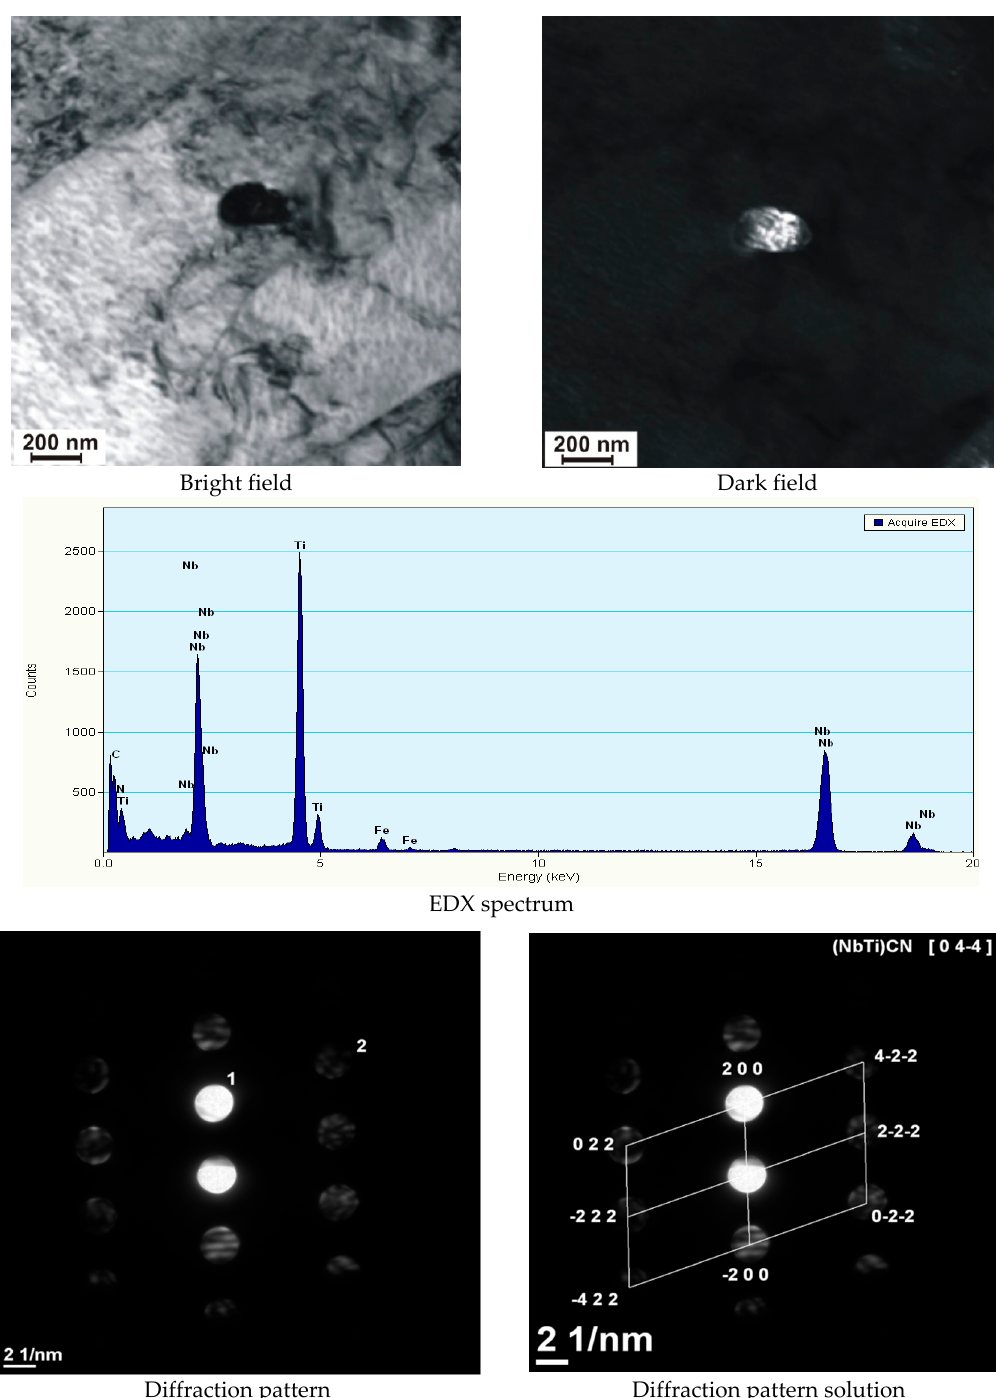
Figure 10. Effect of welding method and heat input on the toughness of the welded joints made of steel S700MC.